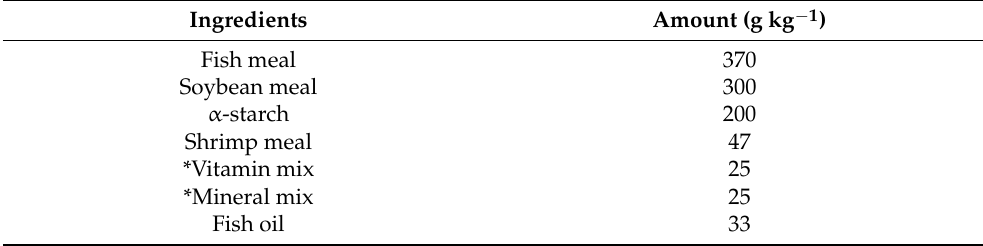
Table 1. Ingredients of the basal diet (g kg − 1 ) used for culturing Litopenaeus vannamei